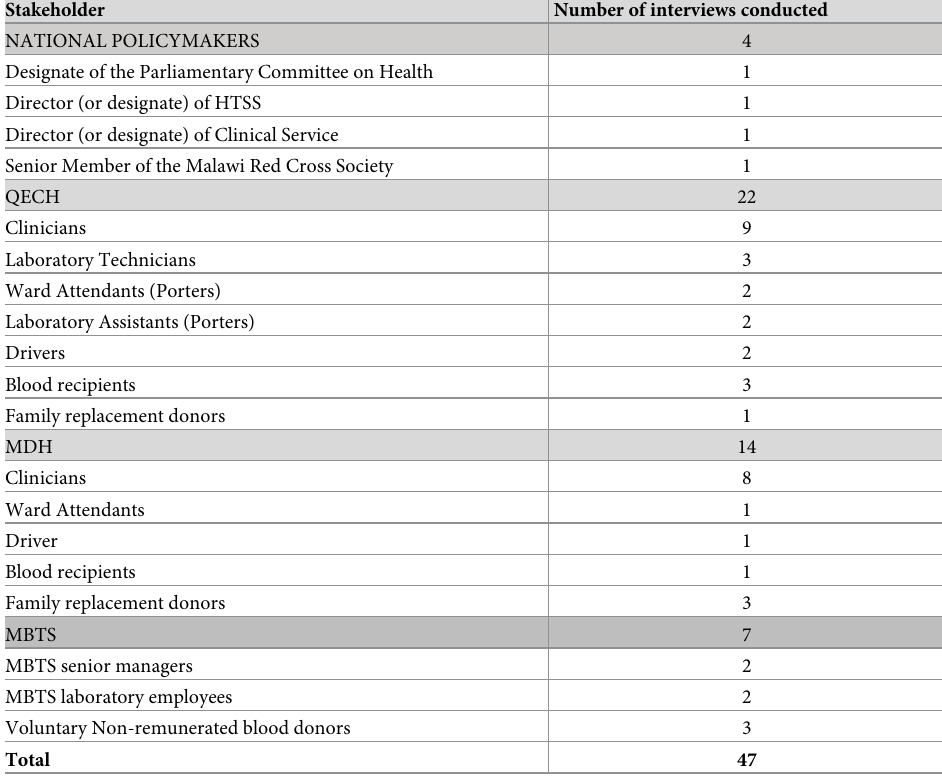
Table 1. Number of IDIs conducted grouped by study site and cadre.